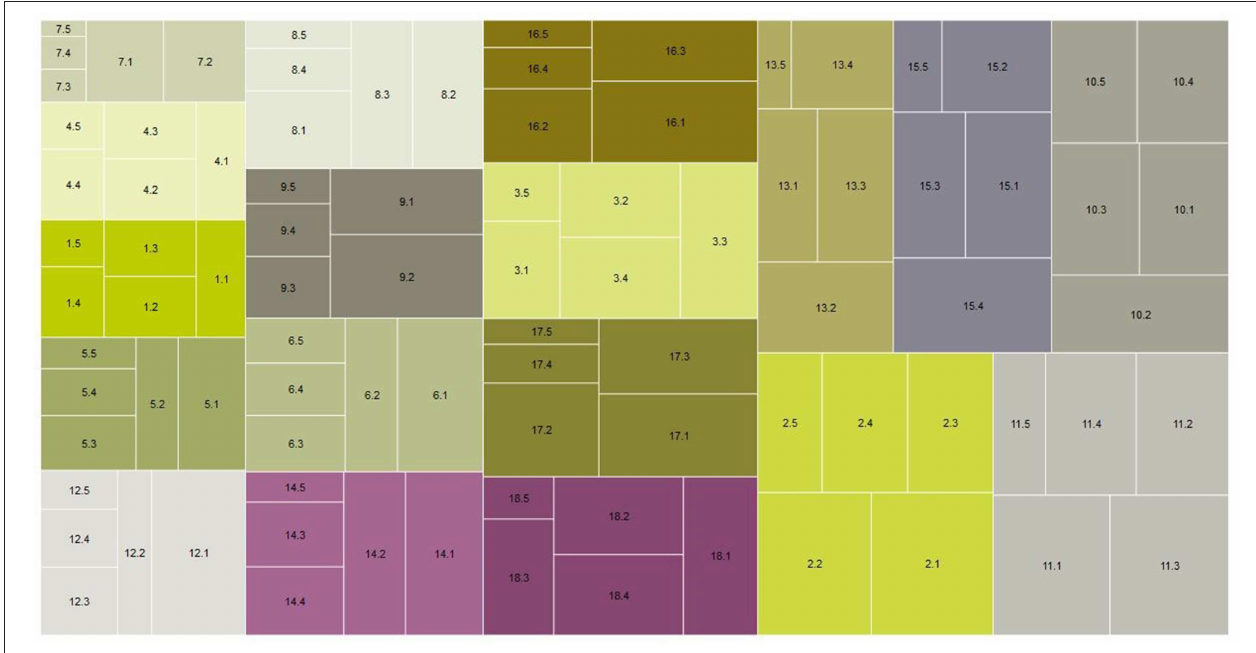
FIGURE 5 | Map tree-diagram of qualitative